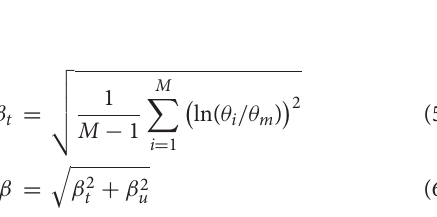
FIGURE 16 | Plan view and three-dimensional model of the hospital building used for the case study (Unit: